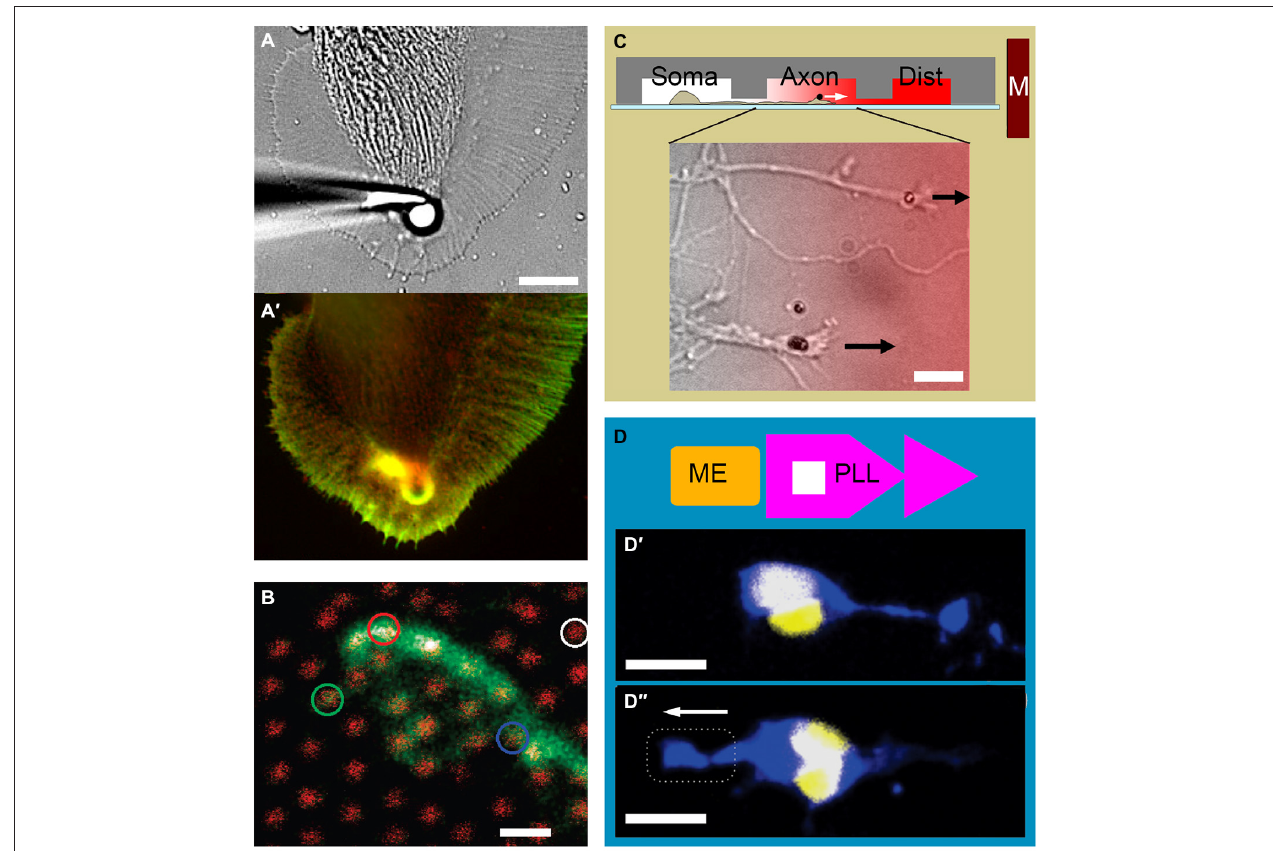
adhesion molecule (NCAM)-functionalized 1.4 µ m superparamagnetic beads. Arrows indicate force direction. Overlay color indicates Semaphorin 3A gradient. Adapted from Kilinc et al. (2014). (D) Combination of adhesive patterning and force application. The substrate consists of an array of “modified fast-forward” poly-l-lysine patterns (PLL; purple) and embedded ferromagnetic elements (ME; gold). (D (cid:48) ) Rat cortical neurons with internalized magnetic nanoparticles polarize in the forward direction in the absence of force. (D (cid:48)(cid:48) ) Neuronal polarization is reverted in the presence of magnetic force. Neurons are stained against Tau protein (blue) and 4 (cid:48) ,6-diamidino-2-phenylindole (DAPI; yellow). Broken line indicates magnet position. Arrow indicates force direction. Adapted with permission from Kunze et al. (2015). Copyright 2015 American Chemical Society. Scale bars = 10 µ m (A) , 1 µ m (B) , 20 µ m (C) , 16 µ m (D)